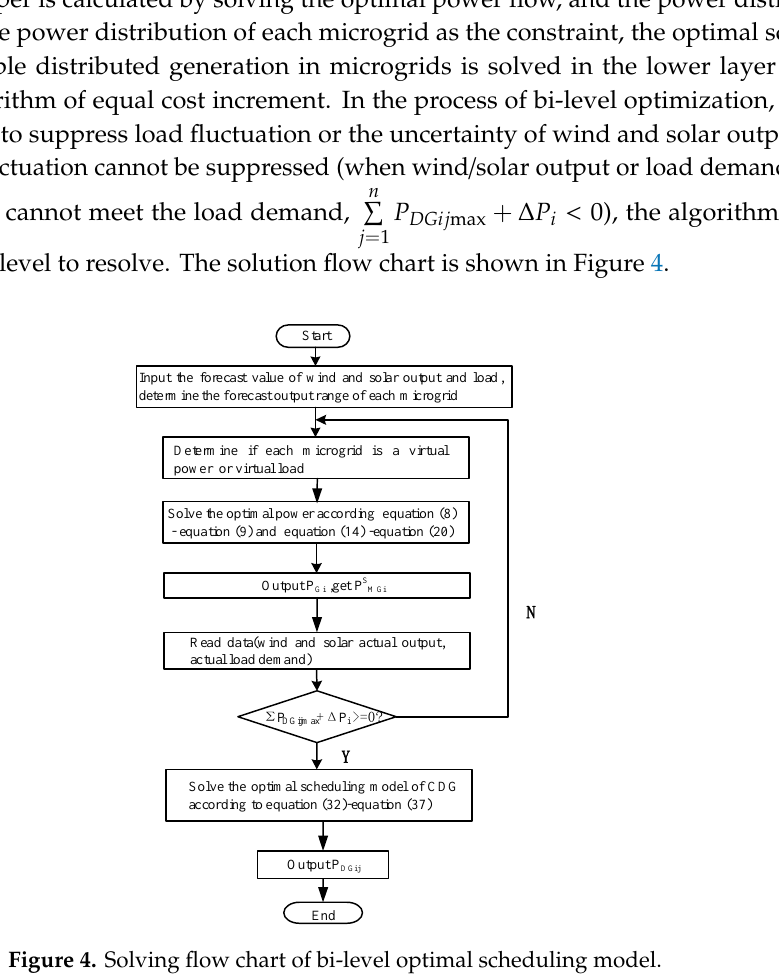
Figure 5. The forecast load demand of each microgrid over 24 hours.